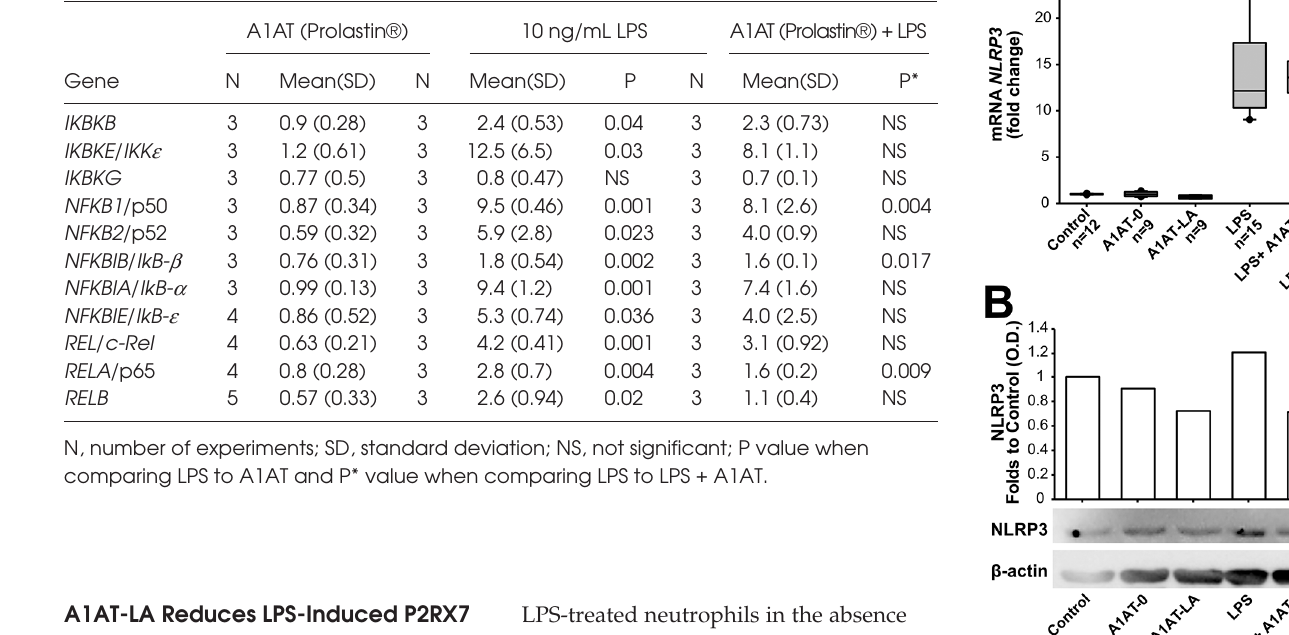
Table 3. Fold changes in NF- κ B pathway mRNA gene expression following neutrophil treatment with LPS and LPS/A1AT (Prolastin®) for 4 h.